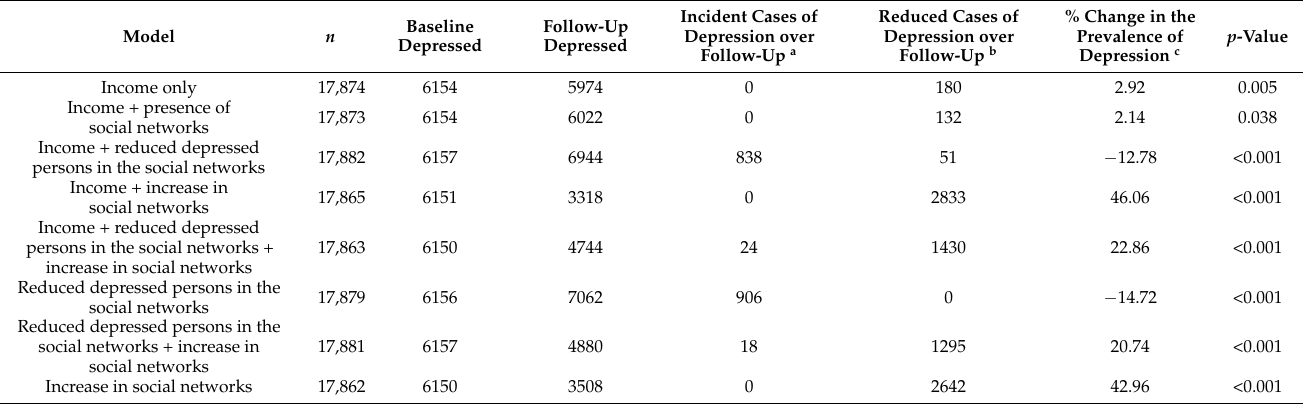
Table 3. Results from the eight agent-based models accounting for simulated changes to social